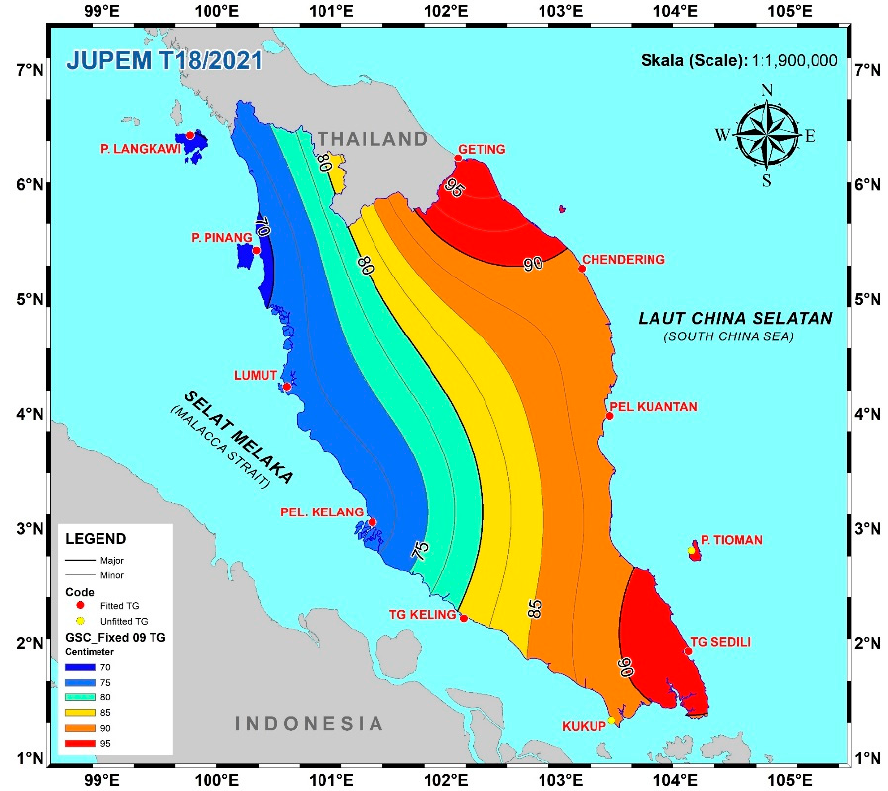
Figure 16. Geoid corrector surface to PMGeoid2022-fit-11TG (CI = 1 cm).